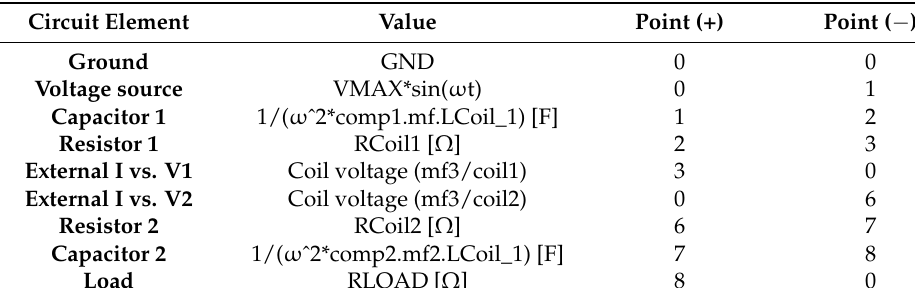
Table 1. Settings of the electronic circuit simulation model.